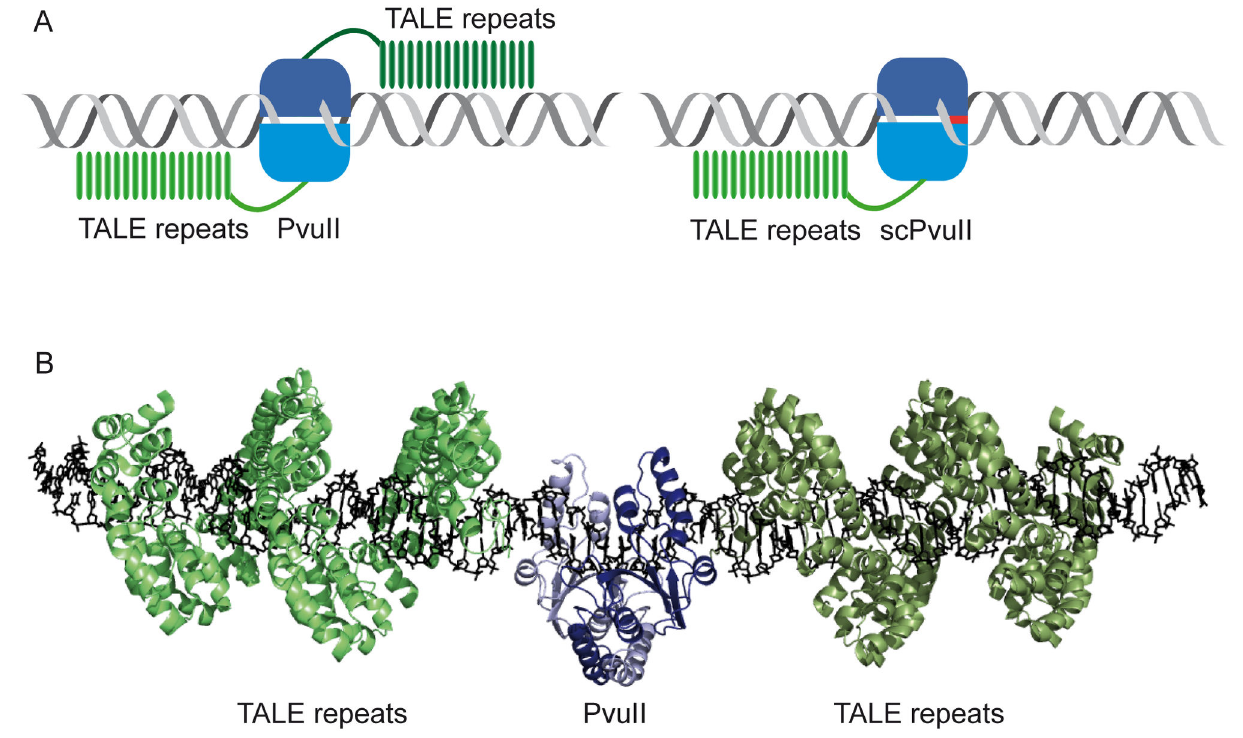
Figure 1. TALE-PvuII fusion proteins. ( A ) Scheme of the architecture of TALE–PvuII fusion proteins. Left: wtPvuII, a homodimer in which the DNA-binding module of a TALE protein is fused via a linker of defined length. Right: scPvuII, a monomeric nuclease in which the DNA-binding module of a TALE protein is fused via a linker of defined length. ( B ) Model of a TALE–wtPvuII fusion protein. The fusion protein is a dimer of identical subunits, each composed of a PvuII subunit and a TALE protein. This model was constructed by aligning the structures of the individual proteins [pdb 1pvi [74] and pdb 3ugm [76]] on a DNA composed of the PvuII recognition site and two TALE target sites up- and downstream of the PvuII recognition site, separated by 6 bp. The C-termini of the PvuII subunits and the N-termini of the TALE protein are separated by about 3 nm. This distance must be covered by a peptide linker of suitable length. The image was generated with